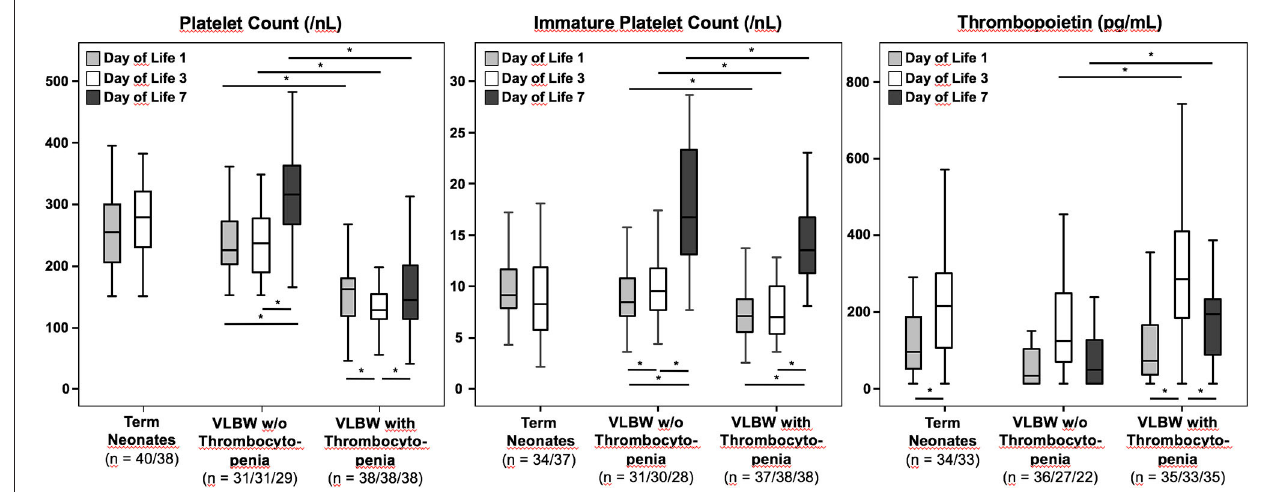
FIGURE 1 | Absolute platelet counts, immature platelet counts, and thrombopoietin plasma concentrations in VLBW preterm infants (with and without thrombocytopenia) and in healthy term newborns. Data were analyzed at different time points: Day of life 1, 3, and 7 for VLBW infants, and day of life 1 and 3 for healthy term controls. The bottom of the vertical lines represents the 5th percentile, the top of the vertical lines the 95th percentile. The bottom and the top of the boxes mark the 25th and 75th percentile, respectively. The median lines mark the 50th percentile (median). Tpo concentrations could only be determined in 95/110, 93/110, and 57/69 blood samples at d1, d3, and d7, respectively, due to a lack of residual plasma in some specimens. * p <